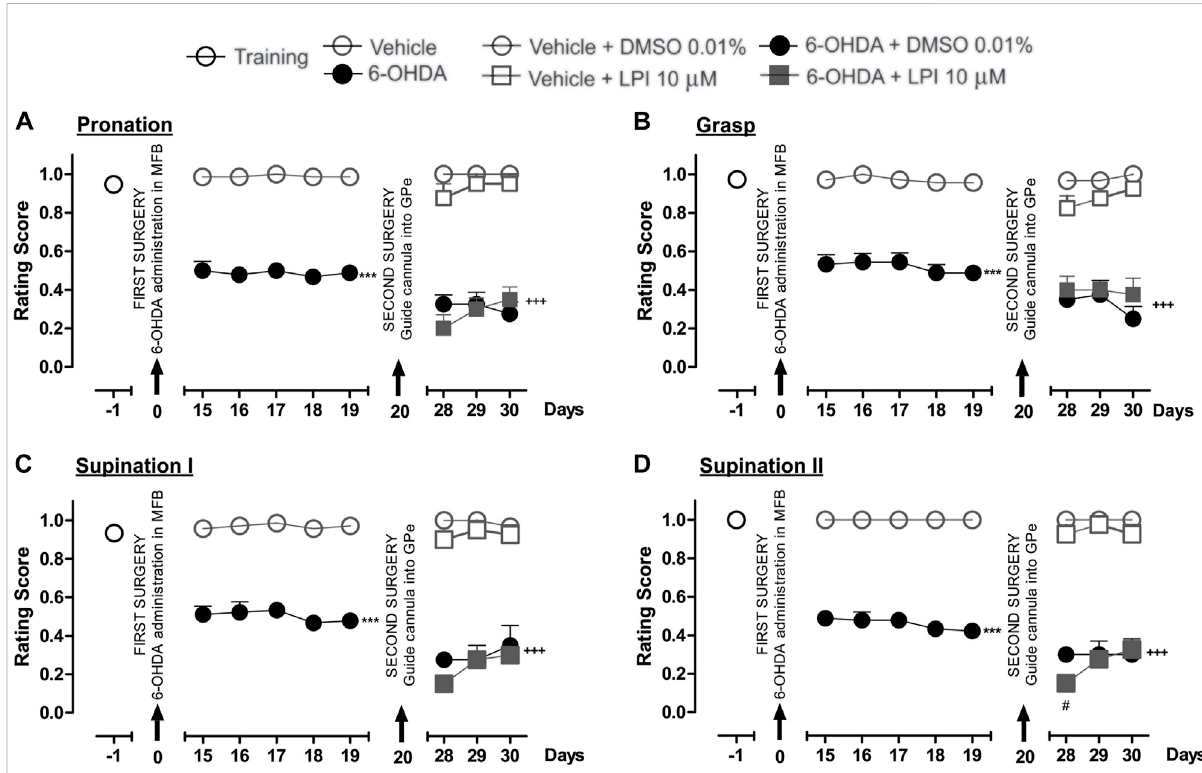
The administration of LPI in the GPe did not affect the fi ne motor skills of the hemiparkinsonian rats evaluated in the staircase test. The four movement components selected to evaluate the contralateral forelimb performance for fi ne motor skills were as follows: (A) Pronation; (B) Grasp; (C) Supination I; and, (D) Supination II. The effect of the intrapallidal administration of LPI (10 µM) on the movement components was evaluated one day prior to the fi rst stereotaxic surgery (from the 15th to the 19th days post-lesion) and from the 28th to the 30th days post-lesion. It is shown that the 6-OHDA + LPI group performed worse in terms of fi ne motor skills than the control groups. Data are represented as the mean ± SEM of the fi ne motor skills scores obtained. *** p < 0.001 vs . vehicle; +++ p < 0.001 vs . vehicle + DMSO 0.01%; # p < 0.05 vs . 6-OHDA + DMSO 0.01%; a two-way ANOVA followed by a Bonferroni post-hoc test, ( n = 5 –